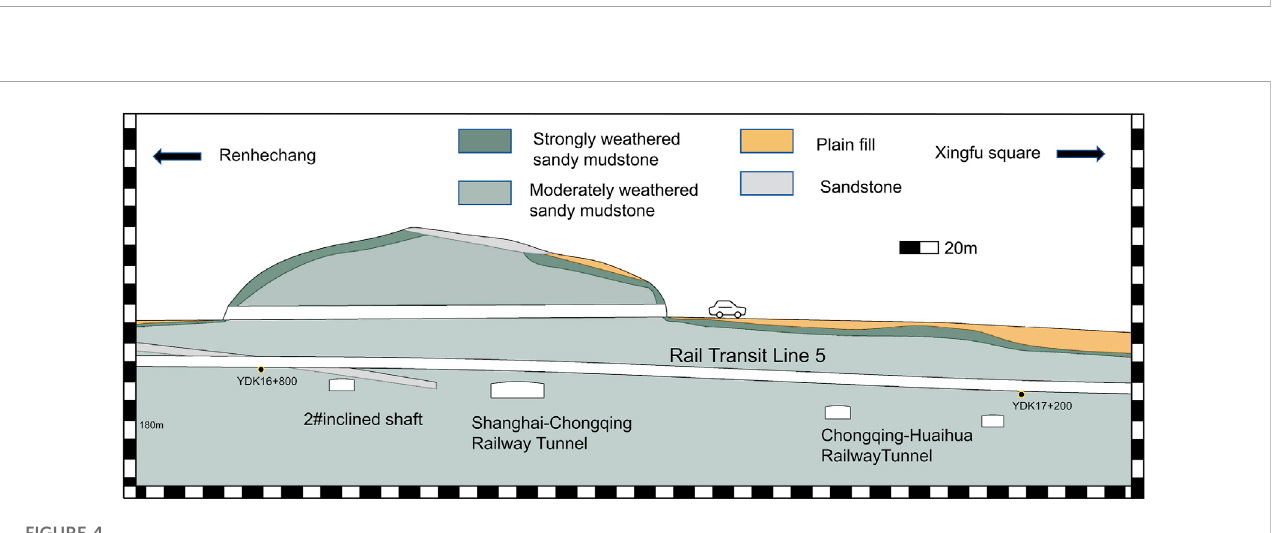
Pro fi le and stratum distribution of adjacent